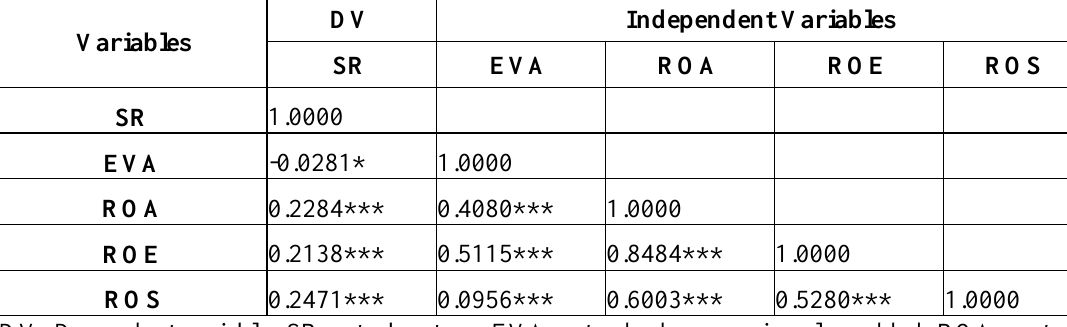
Table 2: Correlation coefficients among dependent and independent variables